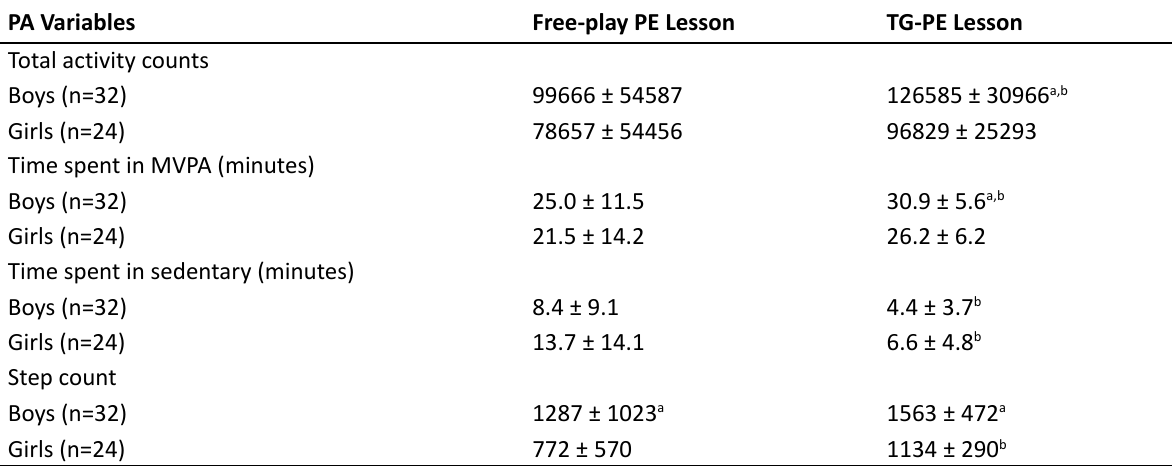
Table 3 . Gender Comparison for Physical Activity Variables between Free-Play PE Lesson and TG-PE Lesson (Mean ±